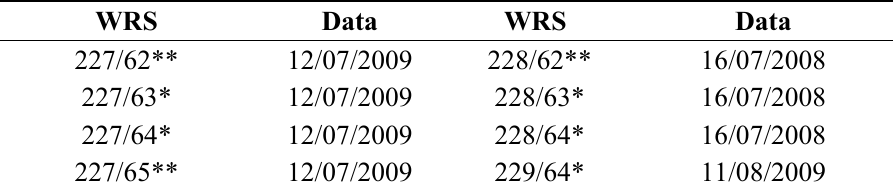
Table 1. Landsat TM5 scenes selected for